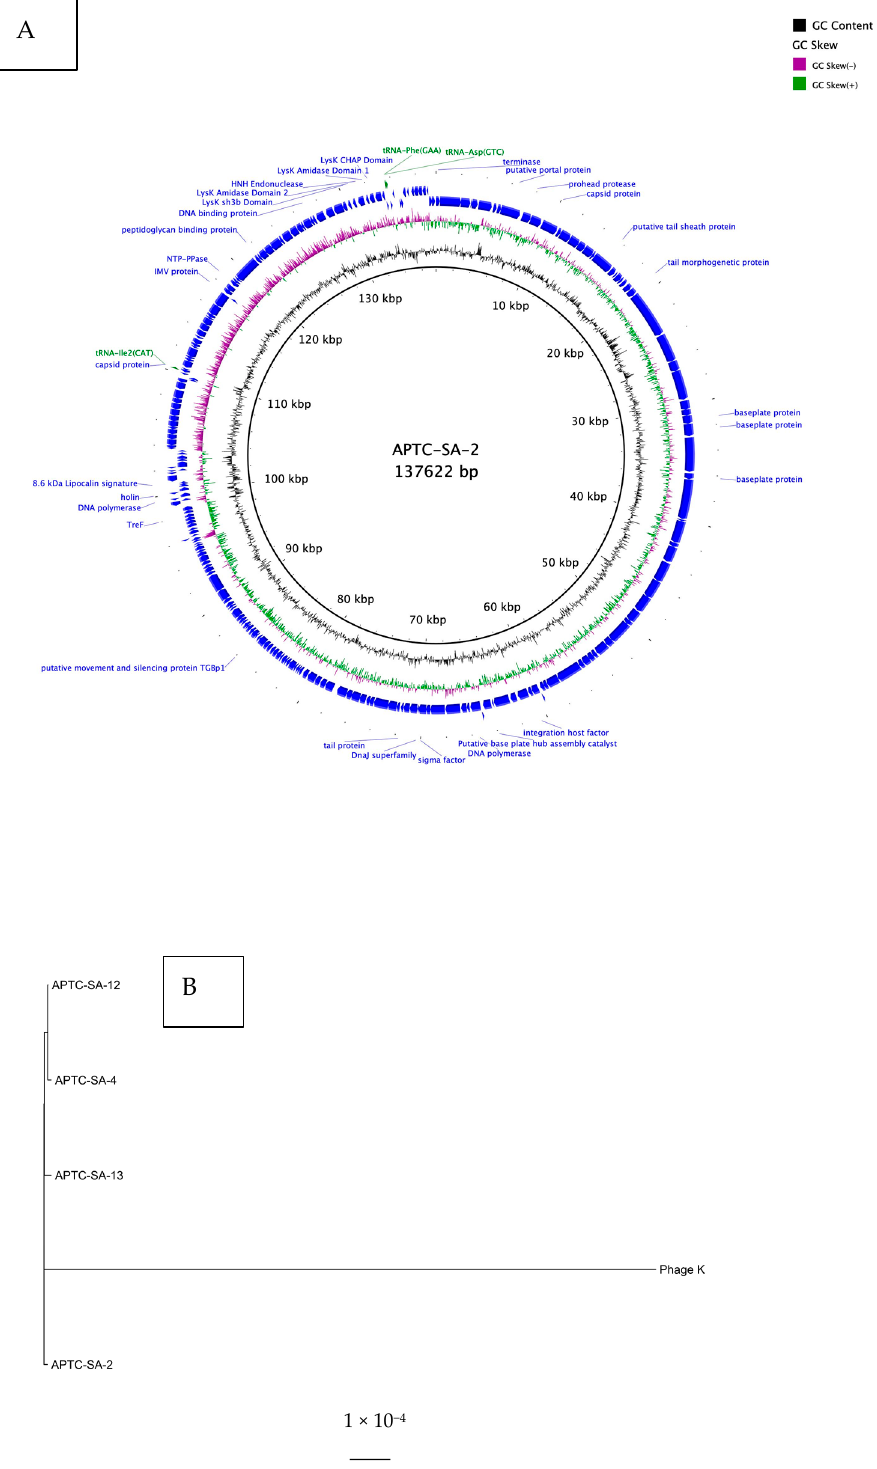
Figure 6. S. aureus phages. ( A ) Map of genomic organization of bacteriophage APTC-SA-2 shown as representative. The open reading frames with predicted annotations are indicated with blue arrows and predicted tRNAs are indicated with green arrows. ( B ) phytogenic tree of phages. A maximum likelihood phylogenetic tree analysis of APTC-SA-2, APTC-SA-4, APTC-SA-12, APTC-SA-13, and phage K was based on their nucleotide sequences.